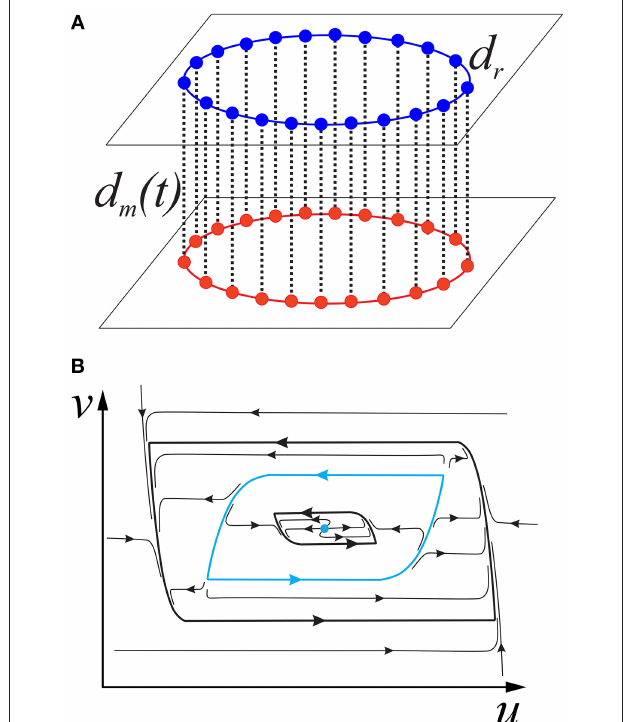
FIGURE 1 | (A) Topology of multiplex network. Red and blue dots depict correspondingly oscillators of first and second layer. Solid and doted lines depict correspondingly intra-layer and (multiplex) inter-layer couplings. (B) Qulitative phase portrait of a single oscillator. There exist two stable limit cycles (bold black lines) separated by an unstable limit cycle (bold blue line) and an unstable equilibrium state (bold blue dot) located at the